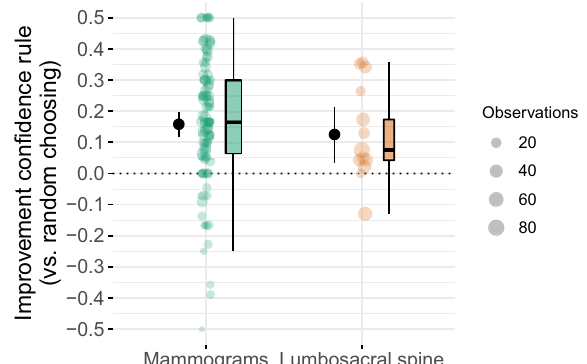
Figure 4. Empirical results comparing the accuracy of the confidence rule to the accuracy of choosing randomly between first and second diagnoses for cases where experts were inconsistent, separately for the two datasets (mammography and lumbosacral spine). The y-axis shows by how much the confidence rule increased accuracy compared to randomly choosing; negative values indicate by how much the confidence rule decreased performance. Experts are shown as horizontally jittered dots; the size of a dot indicates the number of cases for which that expert provided conflicting diagnoses (see the legend labelled “Observations”). The distributions are summarized by boxplots (to the right of the dots); the boxplots consider the number of observations per case (weighted boxplots) and their width is proportional to the square root of the number of experts in the respective distribution. The point and line range to the left of the dots indicate the point estimate of a Bayesian one-sample t-test (median of the posterior distribution of the distribution’s mean, as well as the corresponding 95% credible interval; using the standard “ultrawide” prior scale) 31 . Using the effect size δ (the difference of the mean to zero, divided by the standard deviation) 31 , the increase amounts to 0.76 (median of the posterior distribution of δ ; 95% credible interval, CI 0.55–0.98) in the mammography dataset and to 0.81 (CI 0.19–1.46) in the lumbosacral spine